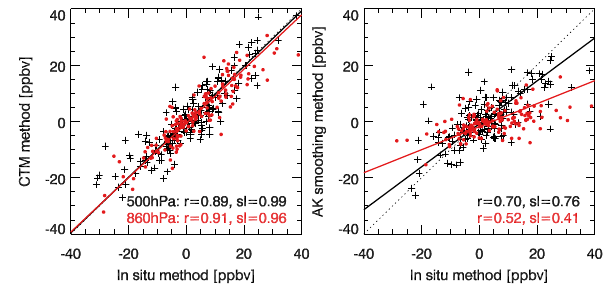
Fig. 6. Differences between TES and OMI estimated by the CTM method (left) and by the averaging kernel (AK) smoothing method (right), relative to the in situ method at 500hPa (black crosses) and 860hPa (red dots). The in situ method uses ozonesonde profiles for 2006 as absolute validation. The data are for 180 TES/OMI/sonde coincidences in 2006. Correlation coefficients ( r ) and slopes of the reduced-major-axis regression lines (sl) are shown inset. Reduced- major-axis regression lines (solid) and the 1:1 line (dashed) are also